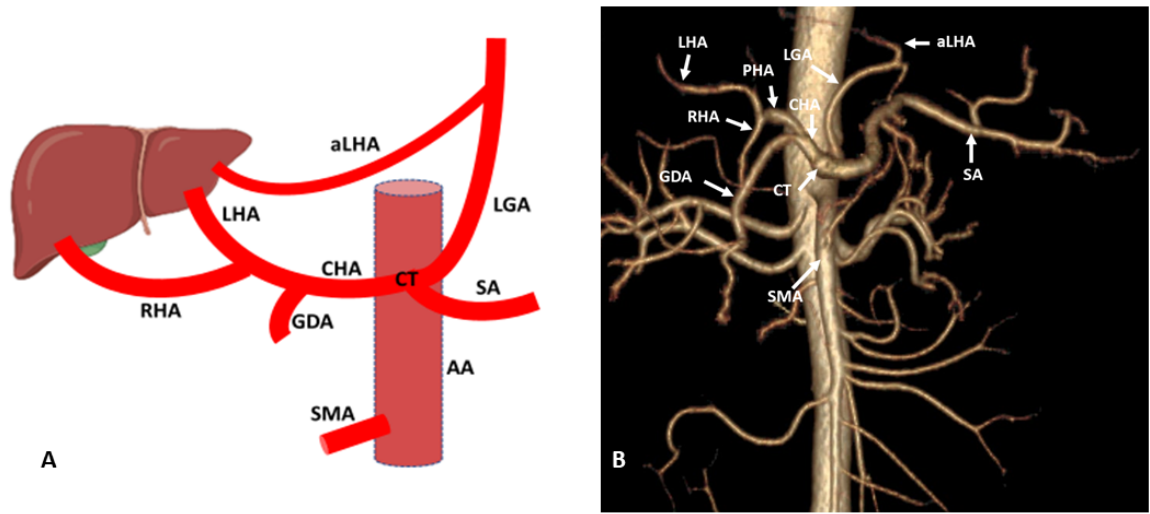
Figure 6. ( A ) Schematic representation of accessory LHA (aLHA) originated from LGA. ( B ) Three- dimensional (3D) volume render (3D-VR) image (64-row scanner CT angiography) of the abdominal region showing the accessory LHA (aLHA) originated from LGA. AA: Abdominal aorta; CT: Celiac trunk; SA: Splenic artery; LGA: Left gastric artery; CHA: Common hepatic artery; PHA: Proper hepatic artery; RHA: Right hepatic artery; LHA: Left hepatic artery; GDA: Gastroduodenal artery; SMA: Superior mesenteric artery.